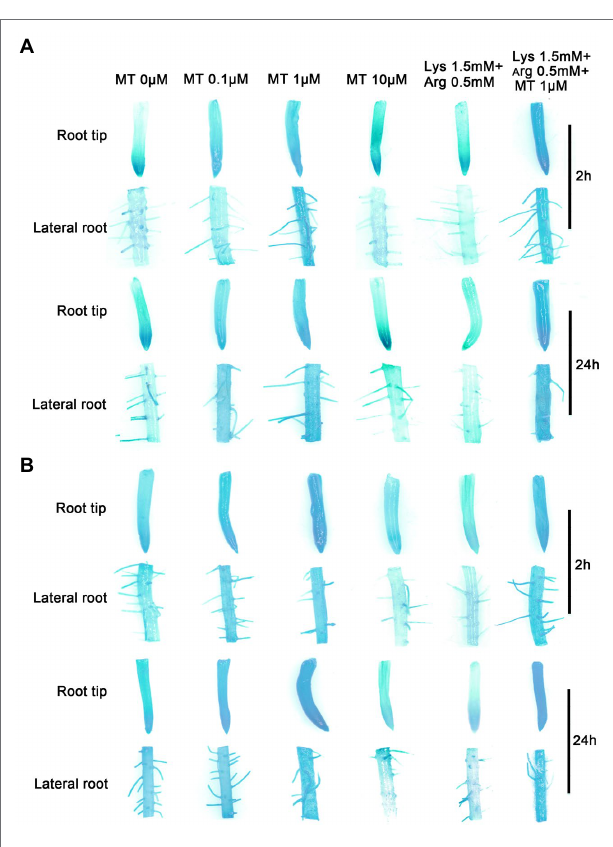
FIGURE 6 | The expression of OsAAP14 and OsGS2 is regulated by melatonin and amino acids. Promoter-GUS transgenic seedlings were grown under basic nutrient solutions supplemented with different concentrations of melatonin (0 μ m, 0.1 μ m, 1 μ m, 10 μ m), 1.5 mm Lys + 0.5 mm Arg, or 1.5 mm Lys + 0.5 mm Arg + 1 μ m melatonin for 2 h and 24 h, respectively. OsAAP14 promoter-GUS staining in the root tip and lateral root (A) . OsGS2 promoter- GUS staining in the root tip and lateral root (B) . MT represents melatonin, Lys represents lysine, and Arg represents